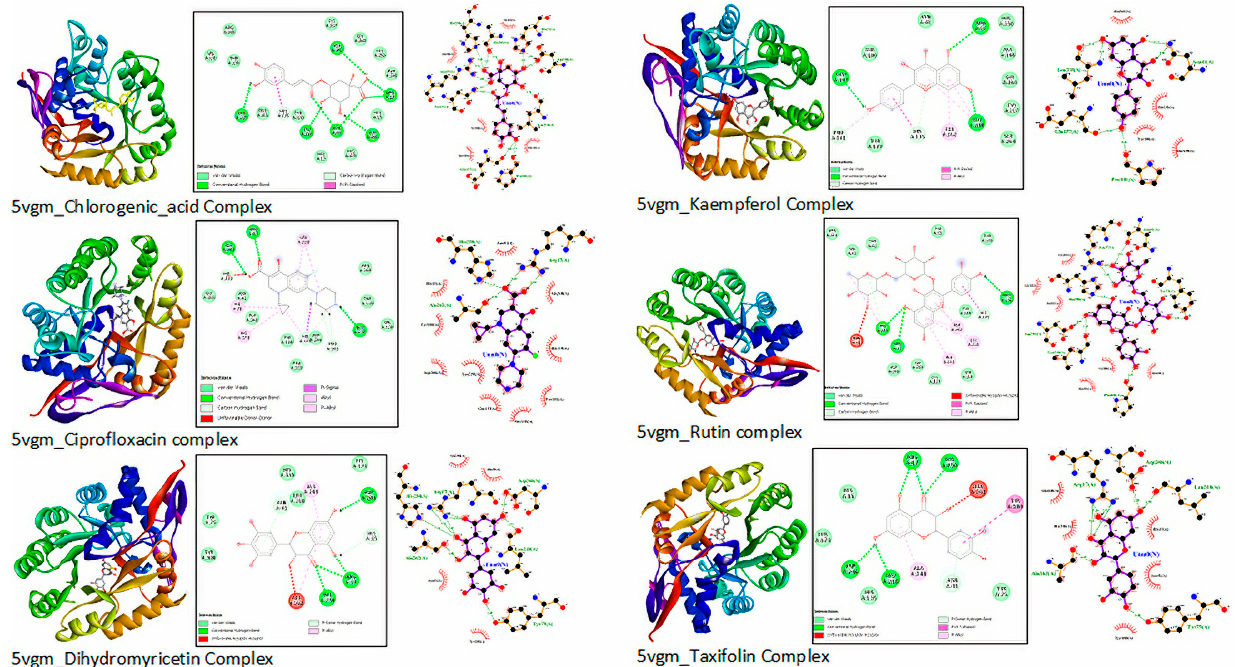
Figure 4. The 3D and 2D views of interactions from Discovery Studio and LigPlot+1.4.5.